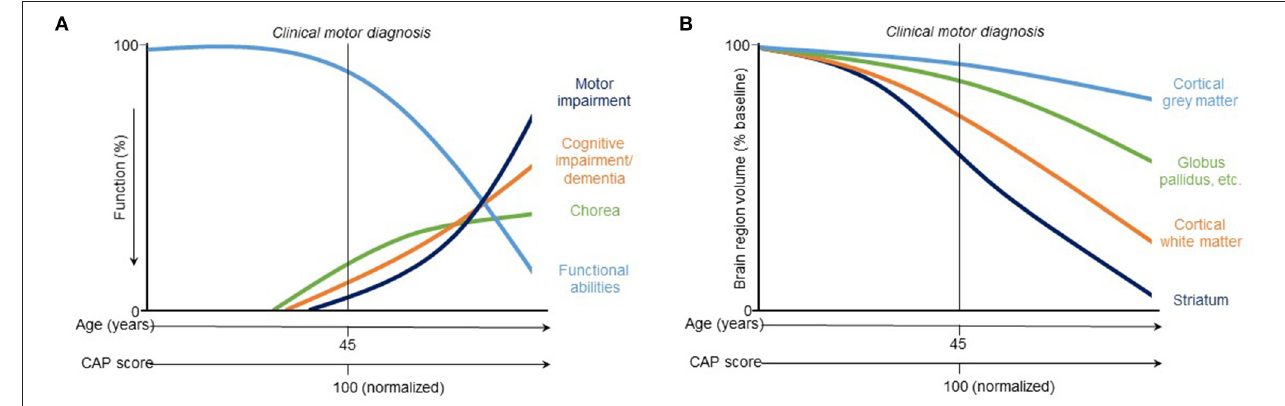
FIGURE 3 | Hypothetical model of trajectories of (A) clinical and (B) vMRI measures of HD progression [modified from Ross et al. (8)]. This qualitative representation is based on observations across two observational study cohorts (PREDICT-HD and TRACK-HD) and provides a conceptual illustration for quantitative trajectory models but has not yet been experimentally